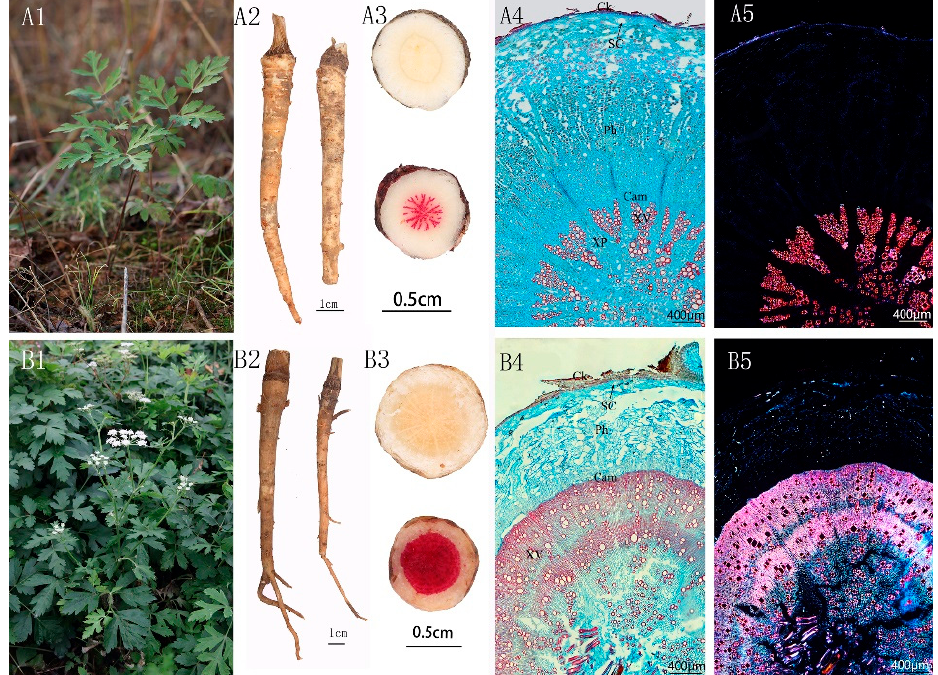
Figure 1. Macroscopic and microscopic morphology of Qianhu. (A: Sample1; B: Sample2) ( A1 ) the Raw plants of Ci Qianhu;( A2 ) the medicinal materials of Ci Qianhu; ( A3 ) the cross-section stained with phloroglucinol and concentrated hydrochloric acid of Ci Qianhu; ( A4 ) observed under a normal light microscope of Ci Qianhu; ( A5 ) observed under polarized light of Ci Qianhu; ( B1 ) the Raw plants of Xiong Qianhu; ( B2 ) the medicinal materials of Xiong Qianhu; ( B3 ) the cross-section stained with phloroglucinol and concentrated hydrochloric acid of Xiong Qianhu; ( B4 ) observed under a normal light microscope of Xiong Qianhu; ( B5 ) observed under polarized light of Xiong Qianhu. CK, cork; Ph, phloem; SC, secretory canals; Cam, cambium; XV, xylem vessels; XR, xylem ray.